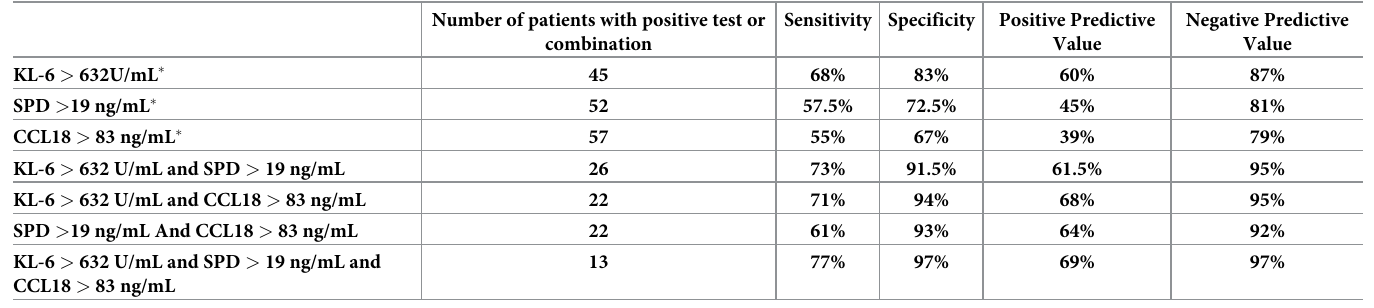
Table 2. Diagnostic performance of circulating markers, alone or in combination, for the diagnosis of RA-ILD. Number of patients with positive test or